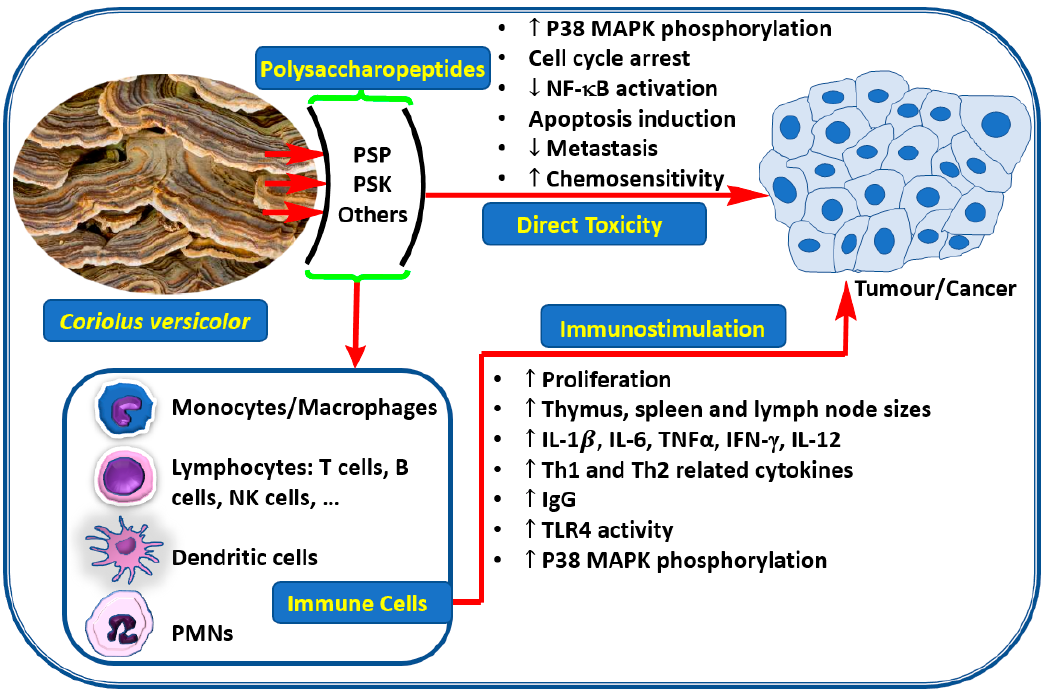
Figure 3. Anti-cancer potential of C. versivolor polysaccharides.